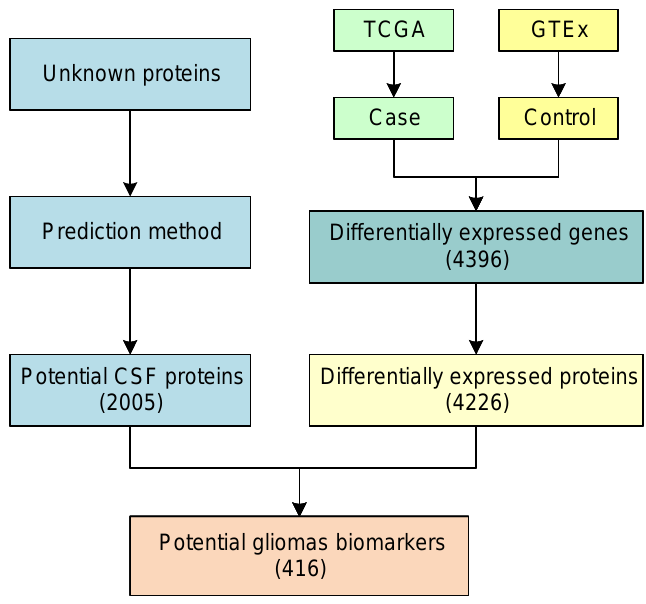
Figure 2. The flowchart of glioma biomarker